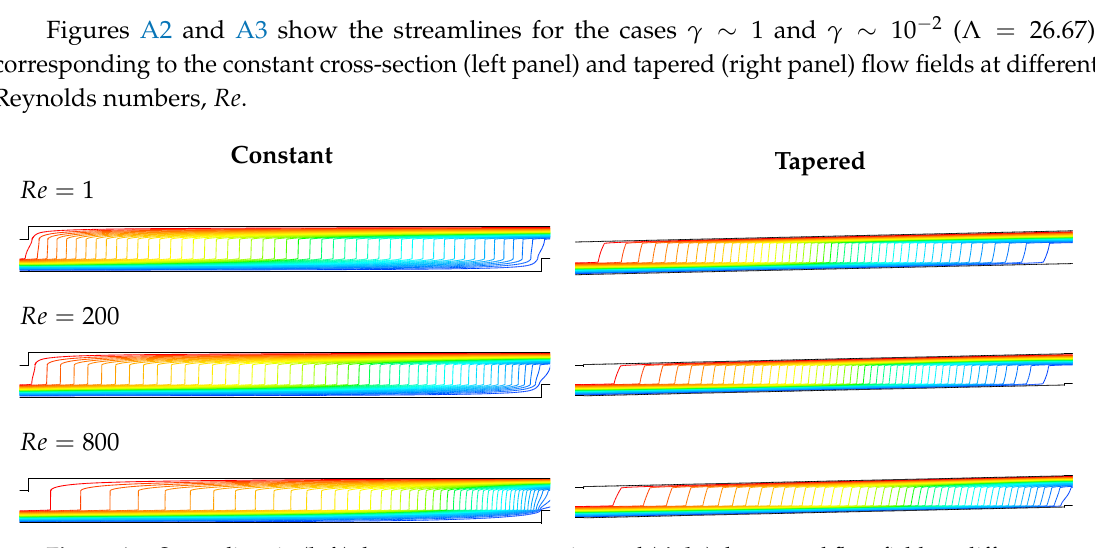
Figure A2. Streamlines in ( left ) the constant cross-section and ( right ) the tapered flow fields at different Reynolds numbers, Re , corresponding to an electrode permeability, K e = 10 − 10 m 2 ( γ ∼ 1 ) , and Λ =